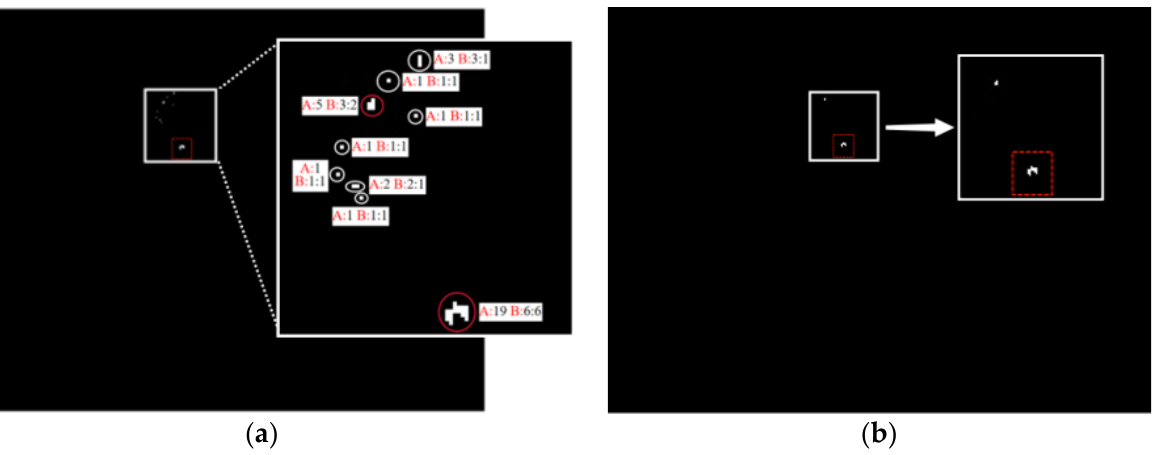
Figure 8. Comparison of before and after shape screening ( a ) image after threshold segmentation and ( b ) image after shape measurement.